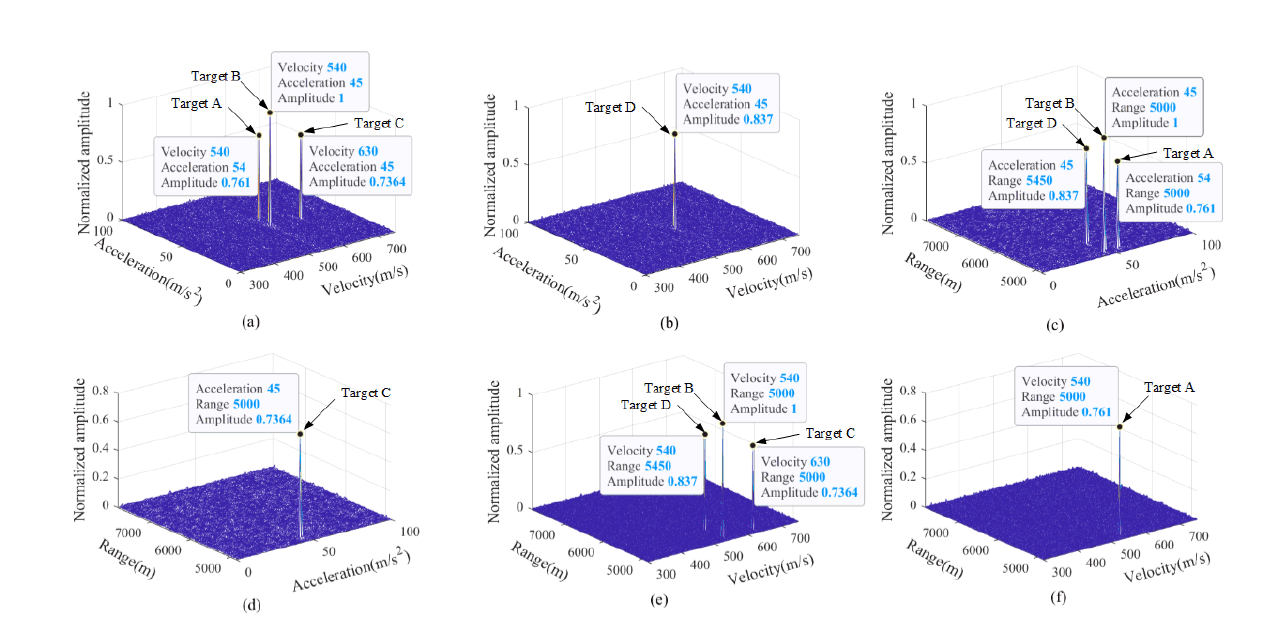
Figure 7. SSJCI outputs of the four targets: ( a ) the velocity–acceleration slice with the range being 5000 m; ( b ) the velocity– acceleration slice with the range being 5450 m; ( c ) the range–acceleration slice with the velocity being 540 m/s; ( d ) the range–acceleration slice with the velocity being 630 m/s; ( e ) the range–velocity slice with the acceleration being 45 m/s 2 ; ( f ) the range–velocity slice with the acceleration being 54 m/s 2 .